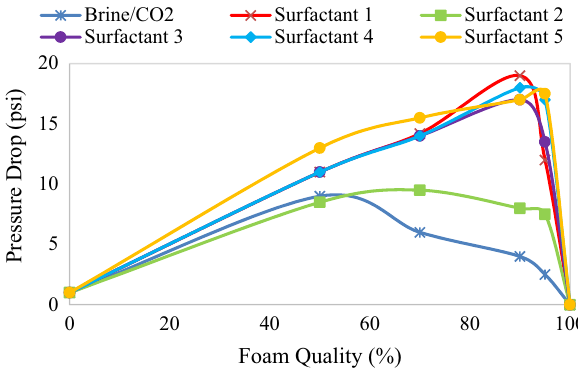
Fig. 6 Pressure drops across the microfluidic chip when CO flooded with brine and surfactant solutions at different foam qualities, and at 100